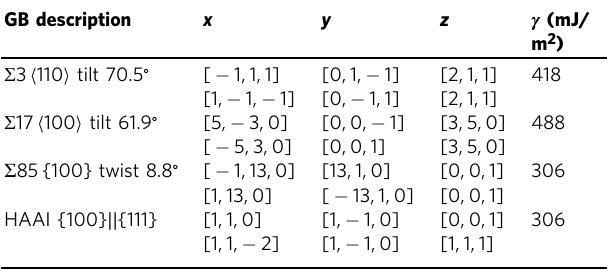
Table 1 Crystallography and 0 K energies of Al